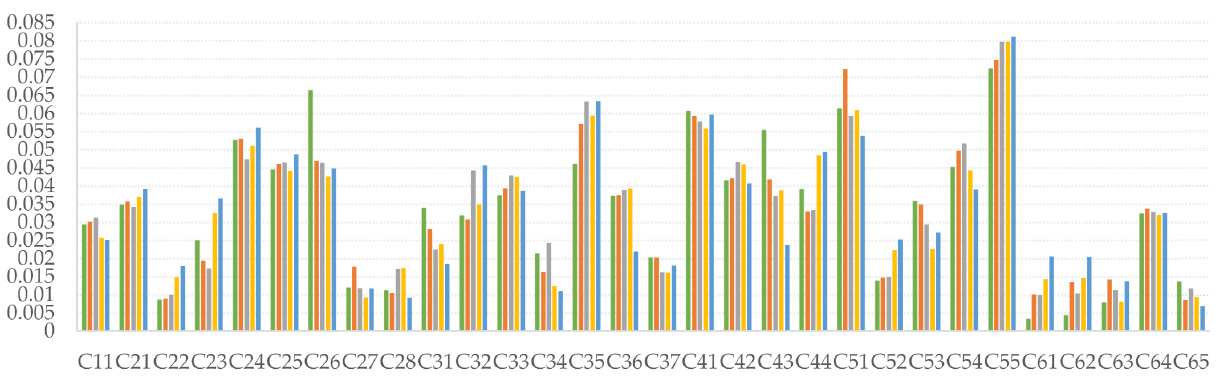
Figure 2. The second-level indicators’ entropy weights from 2009 to 2017.